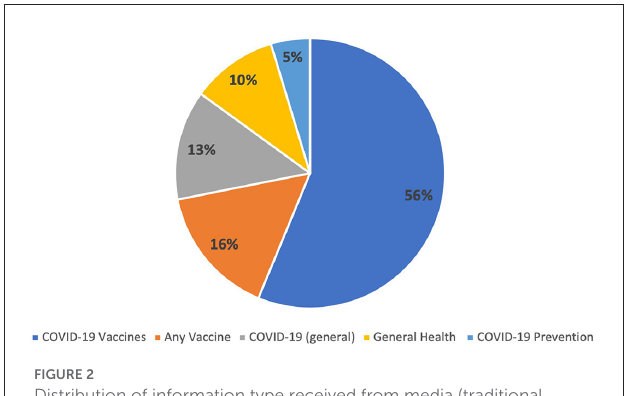
FIGURE2 Distribution of information type received from media (traditional, social, and